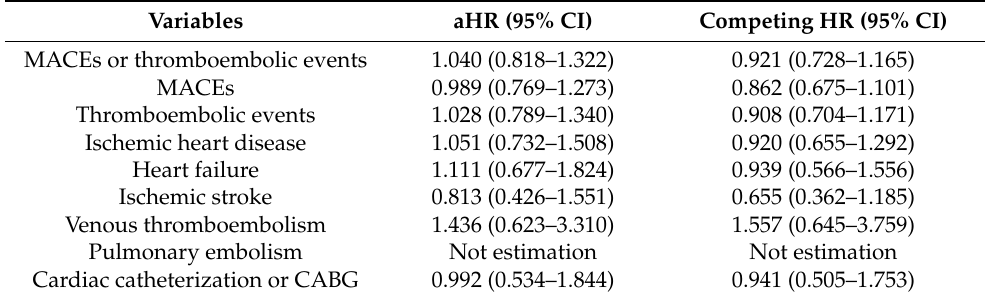
Figure 2. Kaplan–Meier curves for the 6-year cumulative probability of MACEs, thromboembolic events, and all-cause mortality among anti-VEGF cohort and comparator cohort. ( A – D ) shows the cumulative probability of MACEs or thromboembolic events, MACEs, thromboembolic events, and all-cause mortality among age, sex, clinical stage, and time-distribution matched cohorts. ( E – H ) shows the cumulative probability of MACEs or thromboembolic events, MACEs, thromboembolic events, and all-cause mortality among propensity score matched cohorts. Abbreviation: MACEs, major cardiovascular events. Table 4. The adjusted and competing hazard ratio of sub-events in anti-VEGF cohort compared with comparator